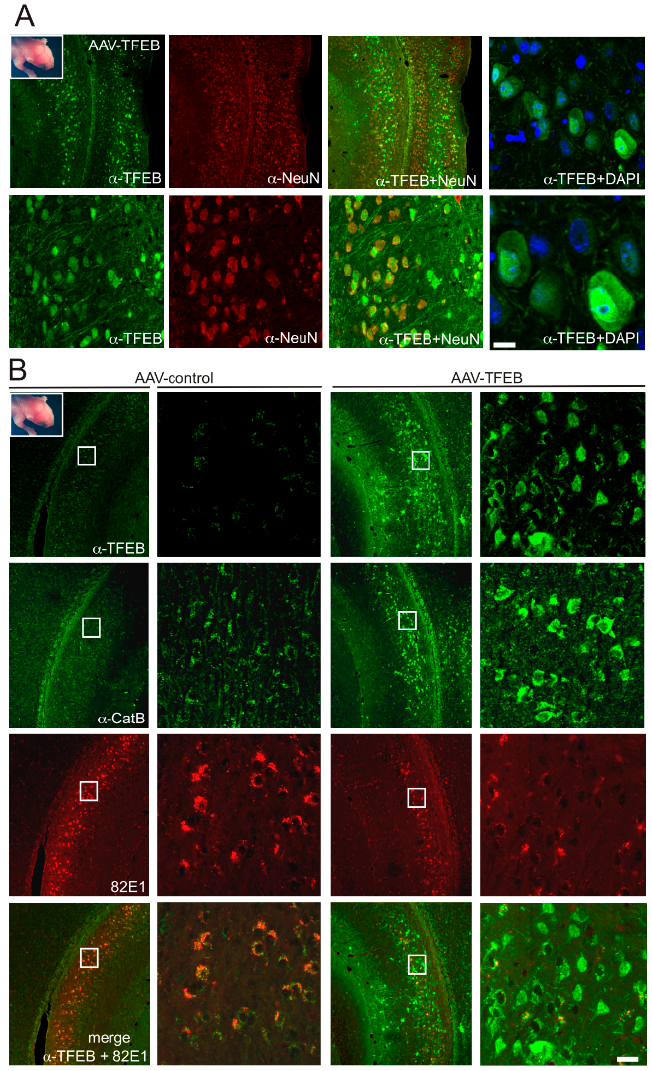
Figure 3. The overexpression of TFEB in the 3xTgAD mouse after intra-cerebro-ventricular injections of AAVs into neonatal 3xTgAD mice leads to neuronal and nuclear TFEB expression and is associated with increased cathepsin expression and a decrease in C99 accumulation. Mice were injected at P0 and analyzed by immunohistochemistry at 8 months of age. ( A ) Left panels show co-immunostaining of TFEB (detected with α -TFEB, green) and the neuronal marker NeuN (red). Right panels show nuclear localization of TFEB as colocalized with DAPI. ( B ) Images illustrate low and high magnification co-immunostaining of TFEB ( α -TFEB, green) and C99 (82E1, red) in AAV-cmv-GFP (left panels) and AAV-cmv-FLAG-TFEB (right panels) mice. Lower panels show merged images of TFEB and 82E1. Middle panels show cathepsin B immunostaining, which was performed on adjacent brain